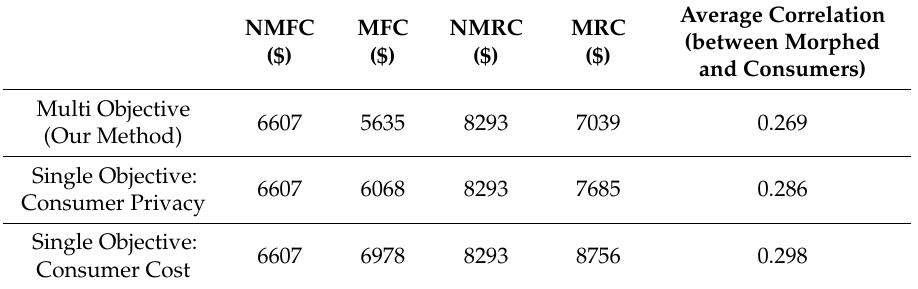
Table 4. Cost ($) and privacy (correlation) measure values computed for Scenario 3 (10 consumers).